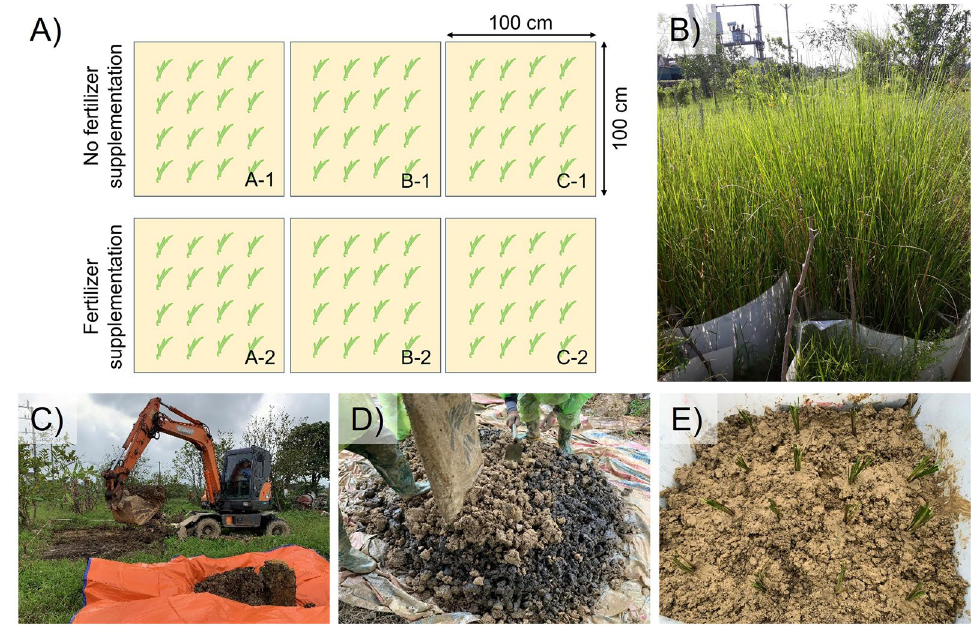
Figure 1. The field trial design. ( A ) Experimental layout; ( B ) selected fresh vetiver before planting; ( C ) soil excavation; ( D ) soil mixing with iron oxide nanomaterials; and ( E ) an experimental lot with vetiver